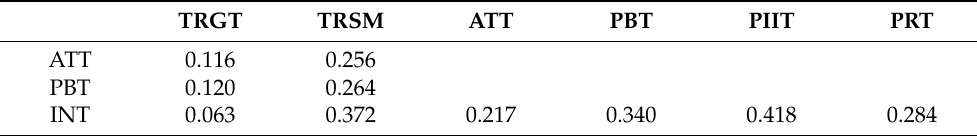
Table 7. Total effect in the structural